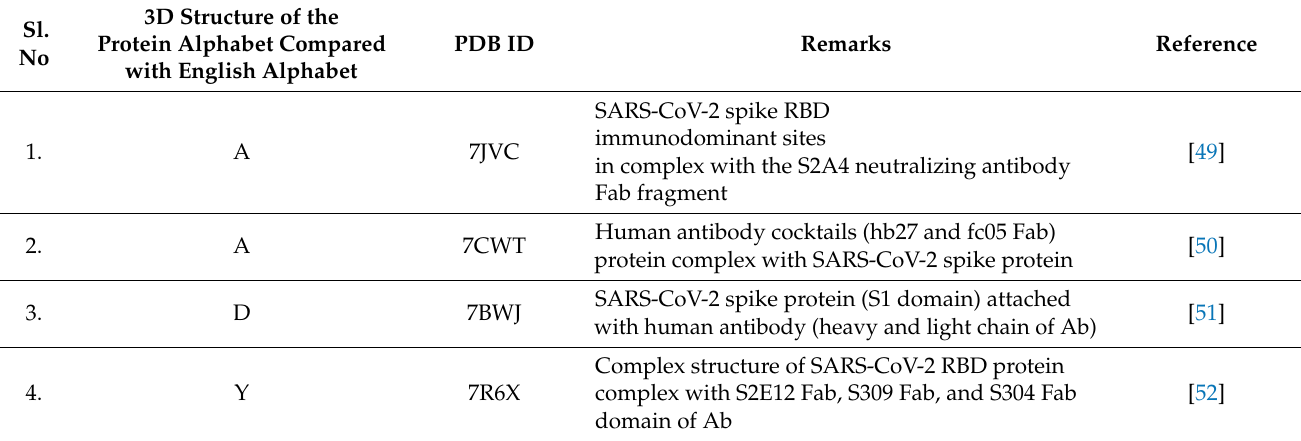
Table 1. The pattern of proteins used in the image comparison study using the protein having antibodies/immunological or vaccine-associated